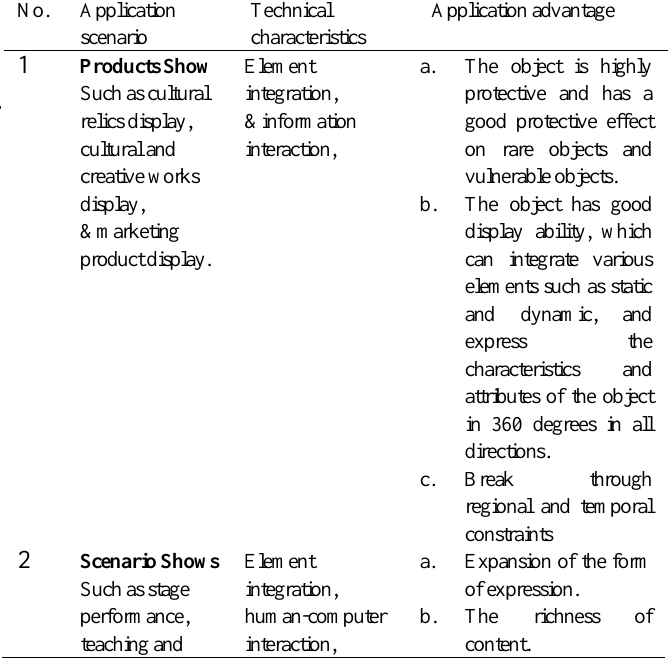
Fig. 7. Theoriginal scene of the old Arcade Street in